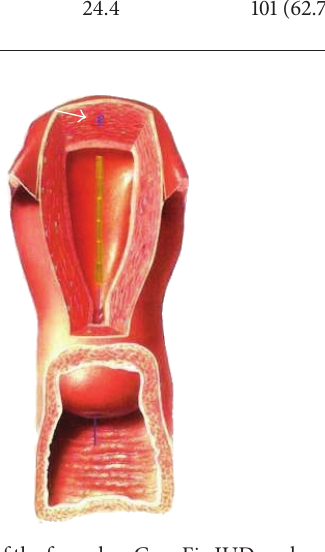
Figure 2: Illustration of the frameless GyneFix IUD anchored in the fundus of the uterus (see arrow). The anchoring knot is inserted in the fundus with a specially designed inserter.